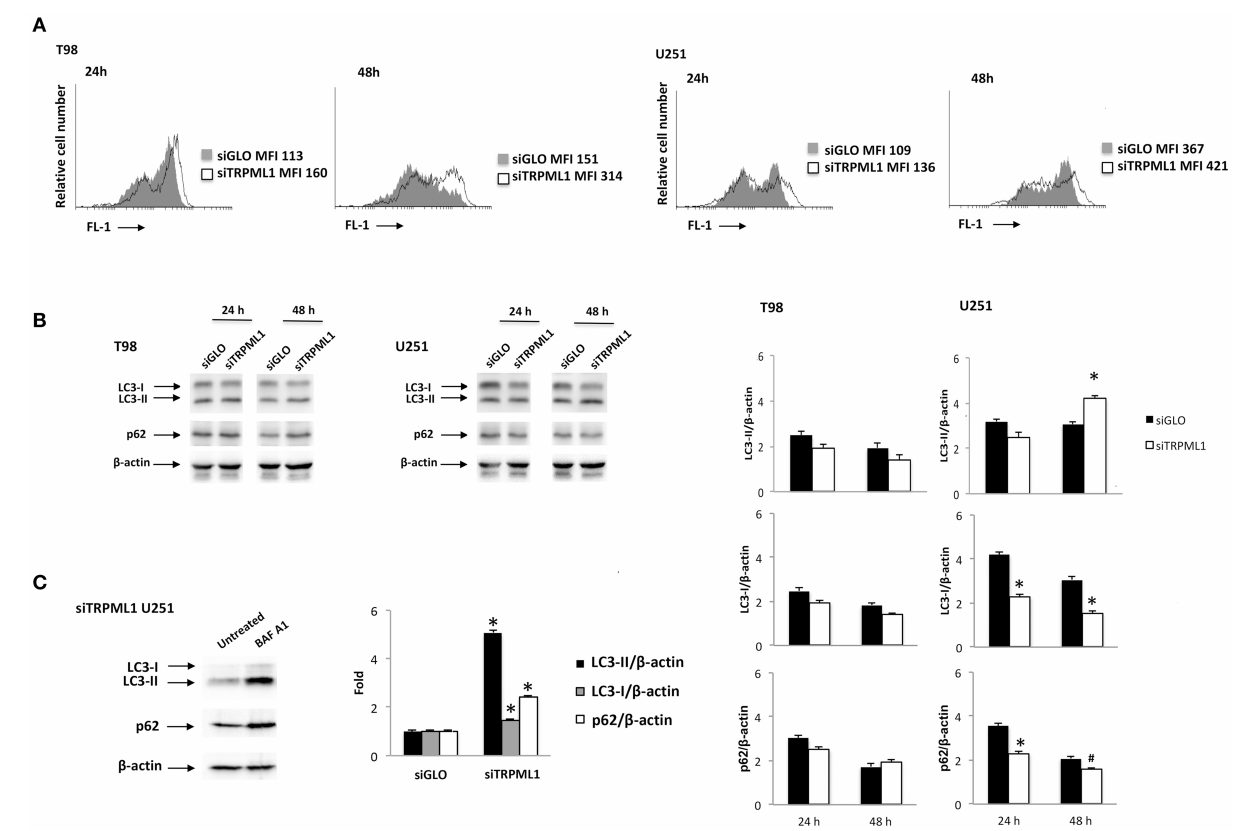
FIGURE 2 | Transient receptor potential mucolipin 1 (TRPML1) silencing induces cellular stress. (A) To detect intracellular NO production, cells were stained with DAF-FM before the flow cytometric analysis. Data are expressed as a percentage of dichlorodihydrofluorescein diacetate (DCFDA) positive cells with respect to